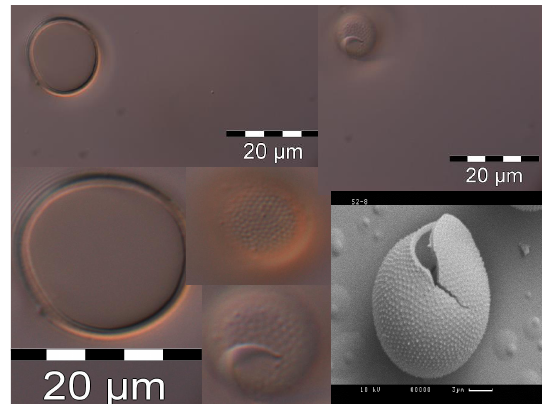
Figure 4. Photos of cysts possibly produced by the so-called snow-algae (species from genera of Chlamydomonas , Chloromonas Haematococcus (Sphaerella) , Chlamydomonas , and Chloromonas ). Photos by Thomas Leya from Fraunhofer IBMT, Culture Collection of Cryophilic Algae and H. Cieszynski, University of